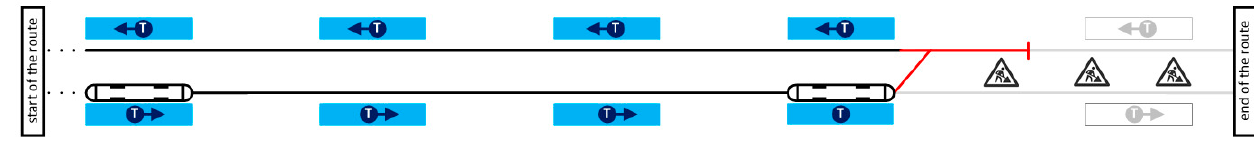
Figure 14. Using the bi-directional tram to serve a tram route in repair.